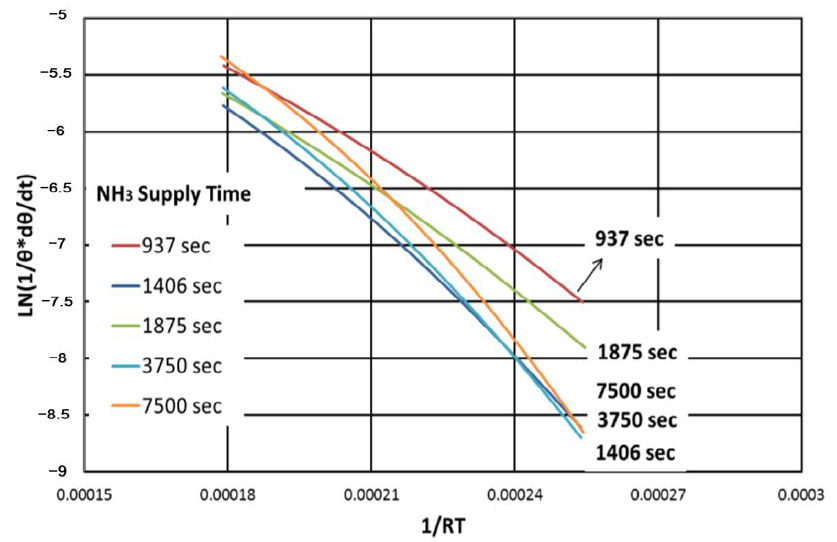
Figure 10. The relationship of the NH 3 desorption rate and temperature for the IT peak.